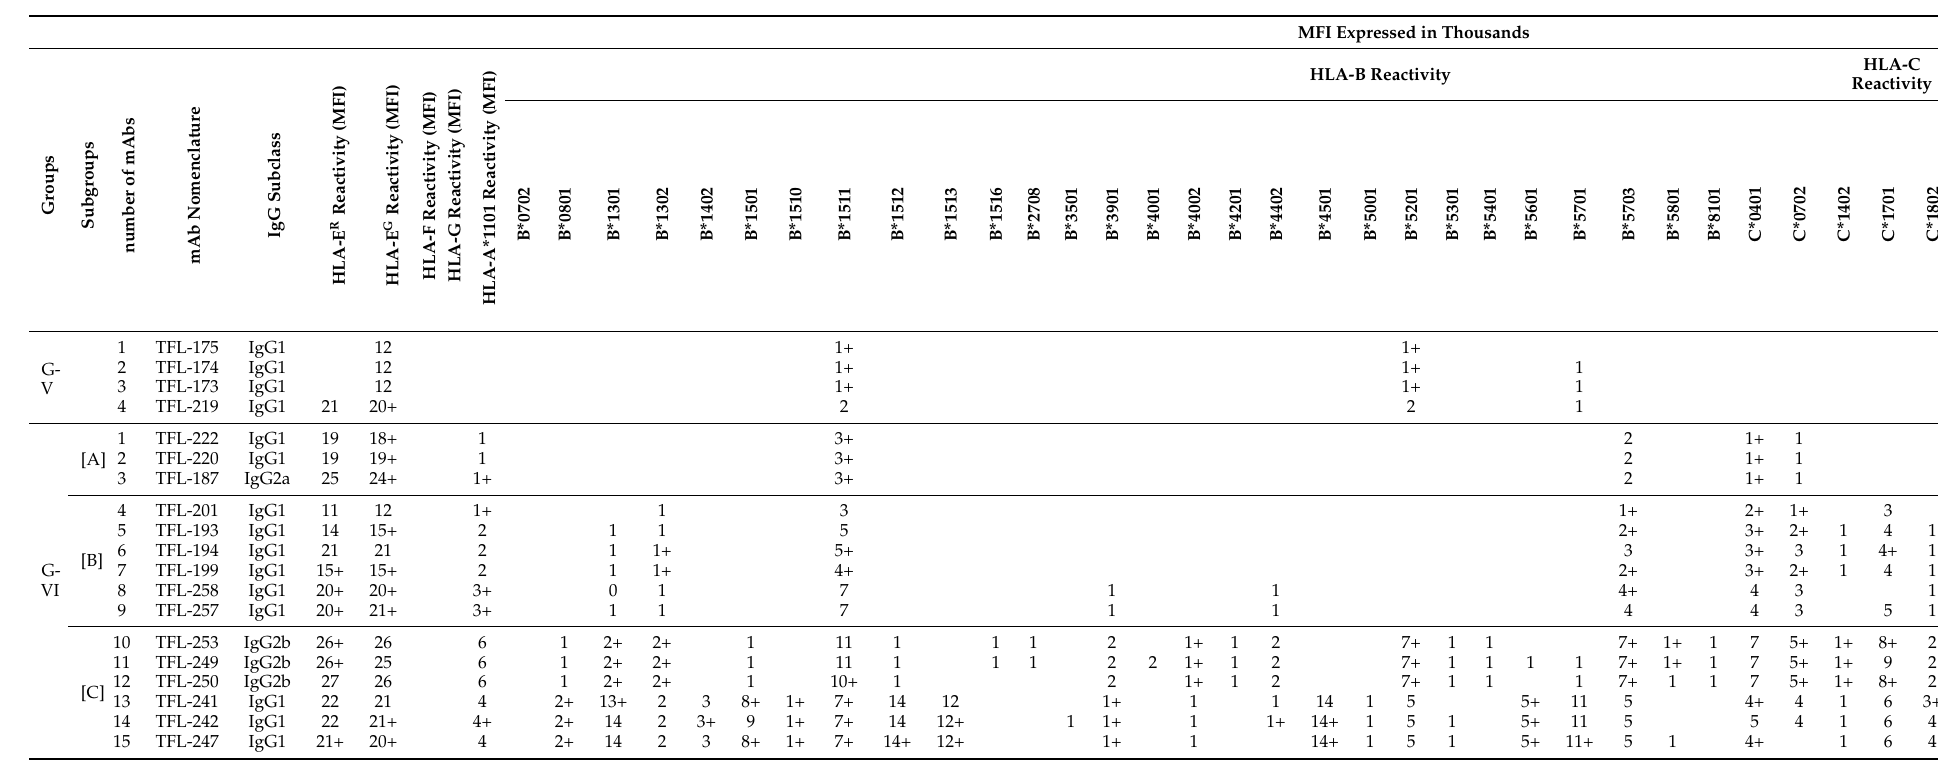
Table 7. HLA-E G mAbs: HLA-F, HLA-G, and HLA-A non-reactive (G-II) or reactive only to HLA-A*1101, and to both HLA-B and HLA-C